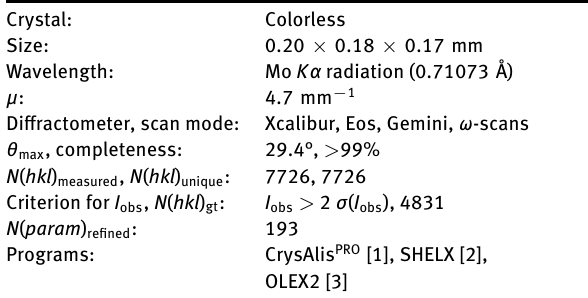
Table 1: Data collection and